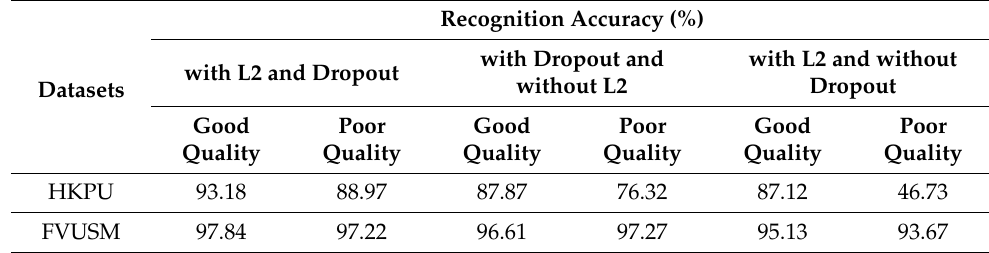
Table 6. Impact of L2 Regularization and dropout on the Recognition Performance of the FVR-Net.